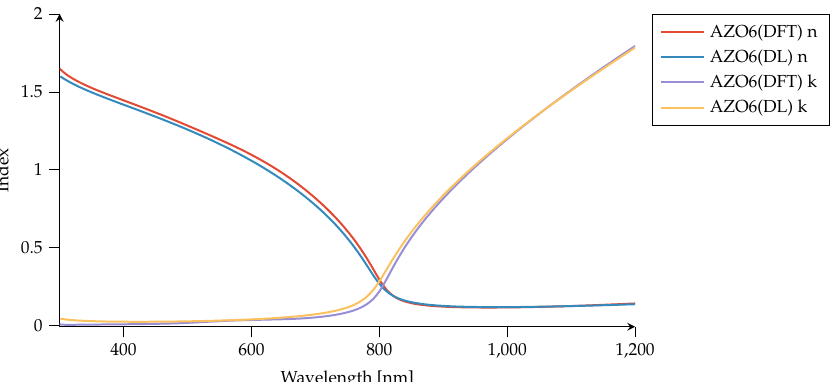
Figure 6. Aluminum-doped zinc oxide (AZO6) comparison of refractive indices ( n , k ). Material model generated via density-functional theory (DFT) [47] are compared to the AZO6 material model generated by Drude–Lorentz (DL) parameters using the Plasmonics Materials Cloud’s materials tool. We use (cid:101) ∞ = 1.8.